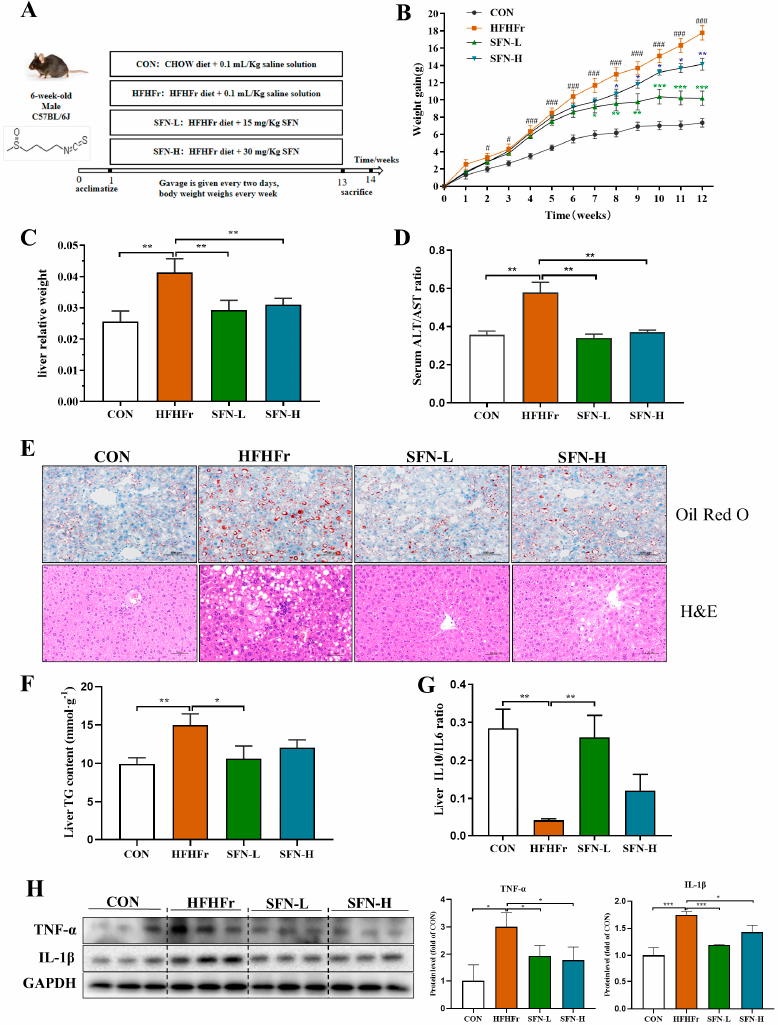
Figure 1. SFN inhibits body weight gain and alleviates hepatic steatosis in HFHFr-fed mice. ( A ) The flow chart of animal treatments. ( B ) Body weight gain curve ( n = 8). ( C ) Liver weight ( n = 8). ( D ) Serum ALT/AST ratio ( n = 6). ( E ) Representative images of liver tissues stained by Oil Red O staining and H&E staining in mice ( n = 6). The scale bar of Oil Red O staining is 100 µ m and the scale bar of H&E staining is 50 µ m. ( F ) Content of TG in livers ( n = 6). ( G ) The ratio of IL-10/IL-6 in the liver was measured by ELISA ( n = 6). ( H ) The protein expression of TNF– α , and IL-1 β in the liver was detected by Western blot ( n = 3). Data are shown as mean ± SEM. * p < 0.05, ** p < 0.01, *** p < 0.001 compared with HFHFr, # p < 0.05, ### p < 0.001 compared with CON. All the experimental procedures were performed according to the Guide for the Care and Use of Laboratory Animals of the National Institutes of Health. The study was ap ‐ proved under the regulations of the Committee on the Ethics of Animal Experiments of China Agricultural University, Beijing (approval ID: Aw10401202 ‐ 4 ‐ 4). 2.3. Dose Information According to previous reports, SFN was orally administered at a dose of 10, 25, and 50 mg ∙ kg − 1 body weight in mice [25–27]. In our study, SFN doses were selected based on previous research and our preliminary experiments. The equivalent low and high SFN